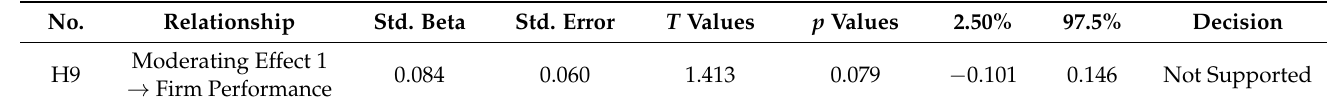
Table 7. Moderation